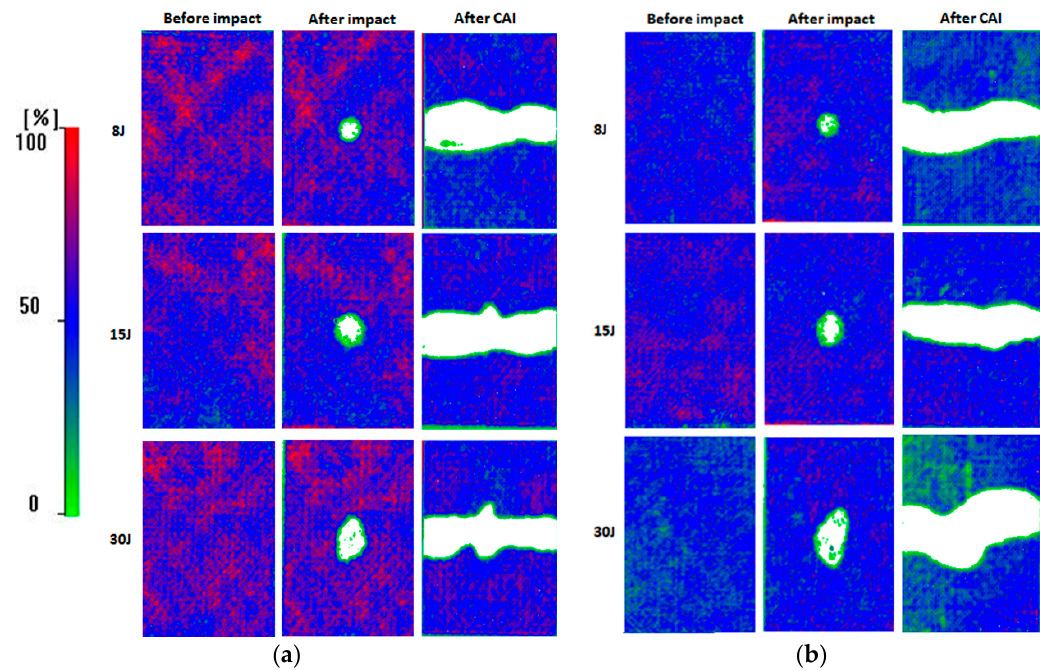
Figure 5. C ‐ scan inspection images before, after impact test and after compression after impact for all energy levels for (a) reference material and (b) nano ‐ modified with 1.5 wt.% MWCNTs concentration.